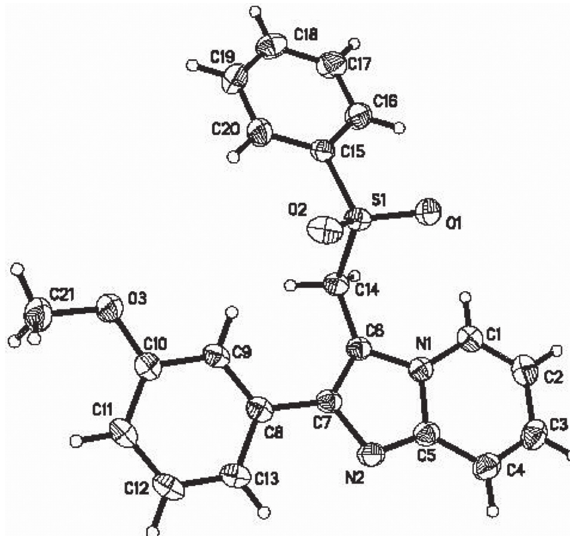
Table 1: Data collection and handling.